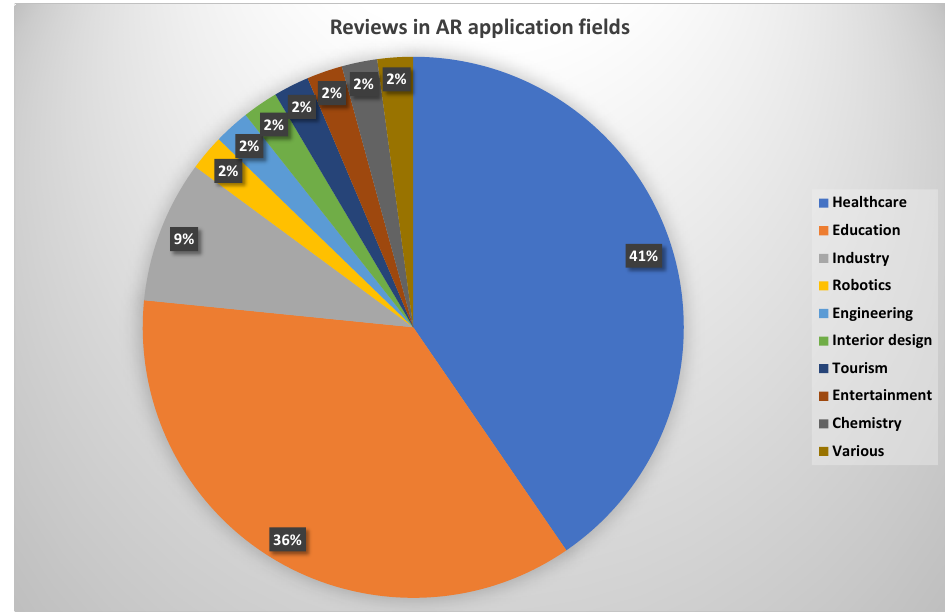
Figure 4. Distribution of review articles over application fields.